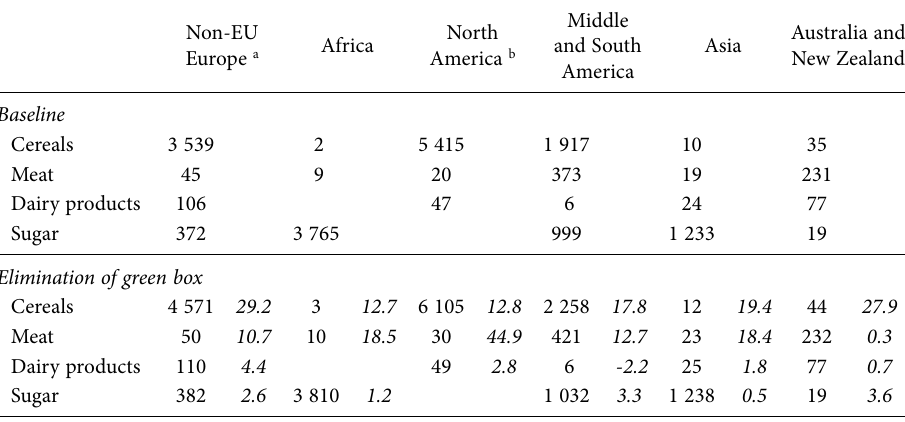
Table 3. Imports to the EU in 2020 by geographic region a and type of scenario (1 000 tons, percent- age change compared to baseline in